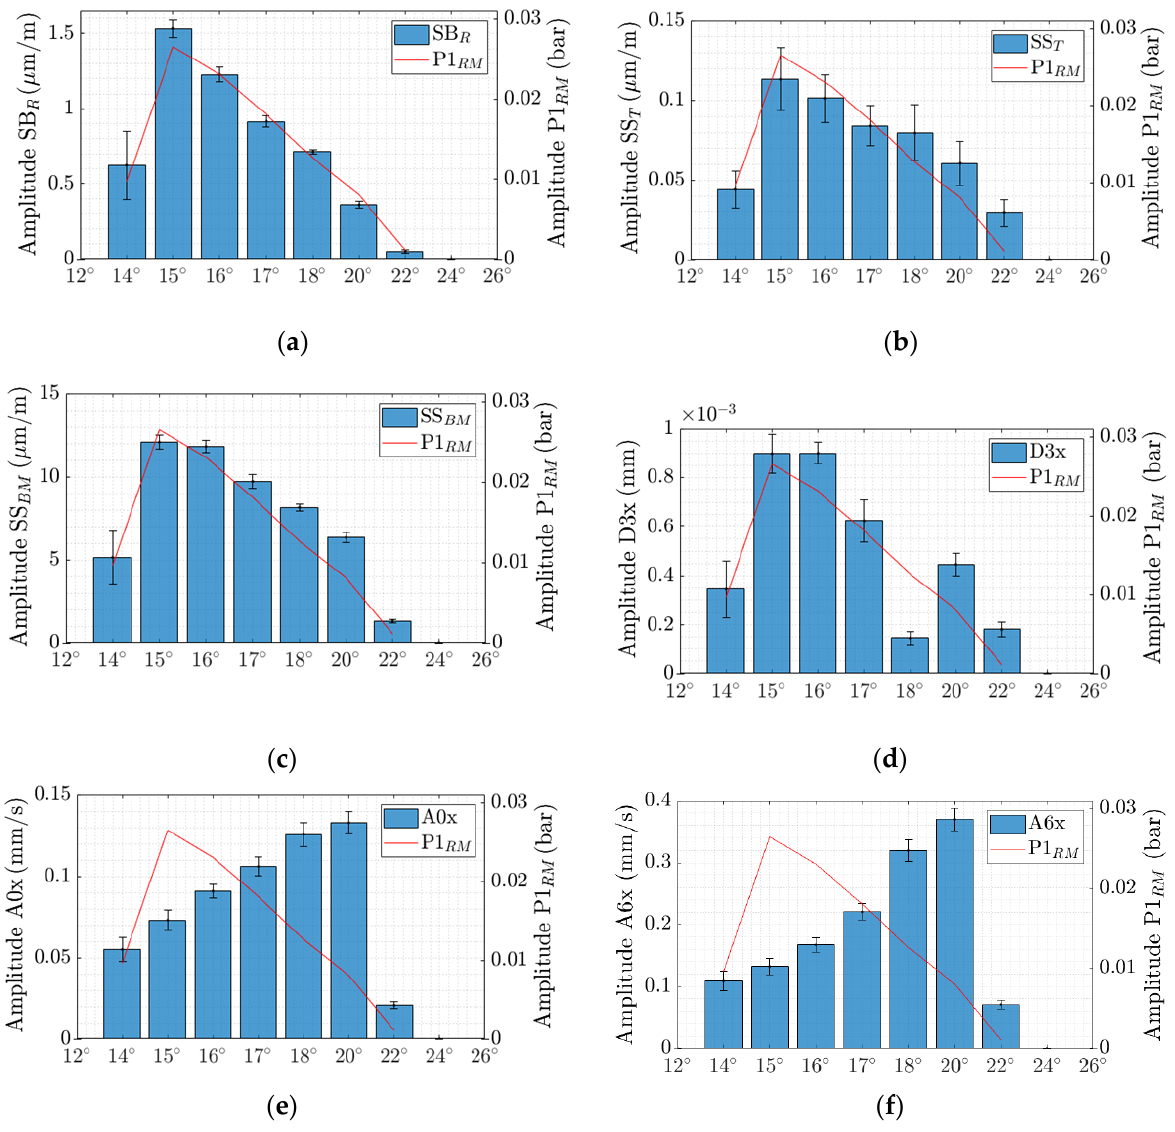
Figure 13. Runner blade strain levels in sensor SB R at f rr ( a ), shaft strain levels in sensor SS T at f rr ( b ) and SS BM at f rr ( c ), shaft relative displacement levels above the turbine bearing in sensor D3x at f sr ( d ), and vibration velocity levels on the draft tube in sensor A0x at f sr ( e ) and on the upper generator bearing in sensor A6x at f sr ( f ) at α from 12° to 26°.